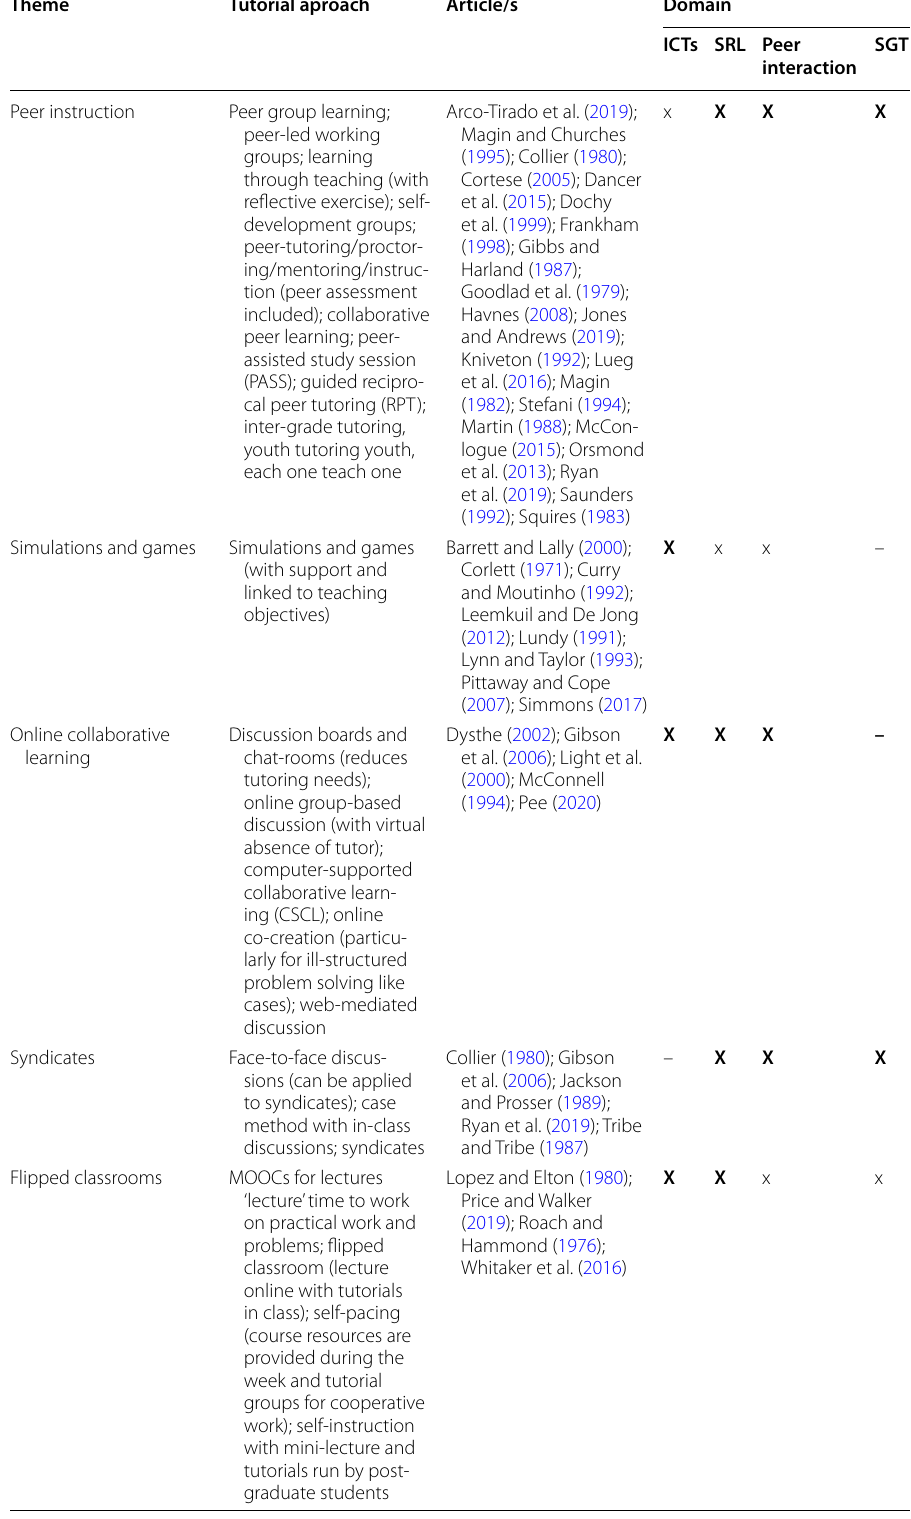
Table 3 Charting the data from included studies to map alternative models for tutorials